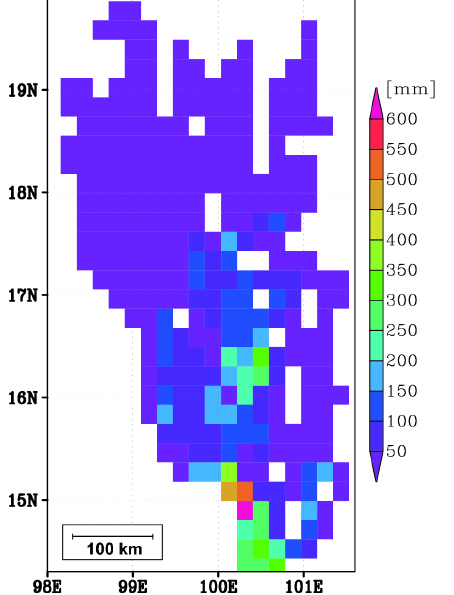
Figure 5. Annual accumulated irrigation water withdrawal.